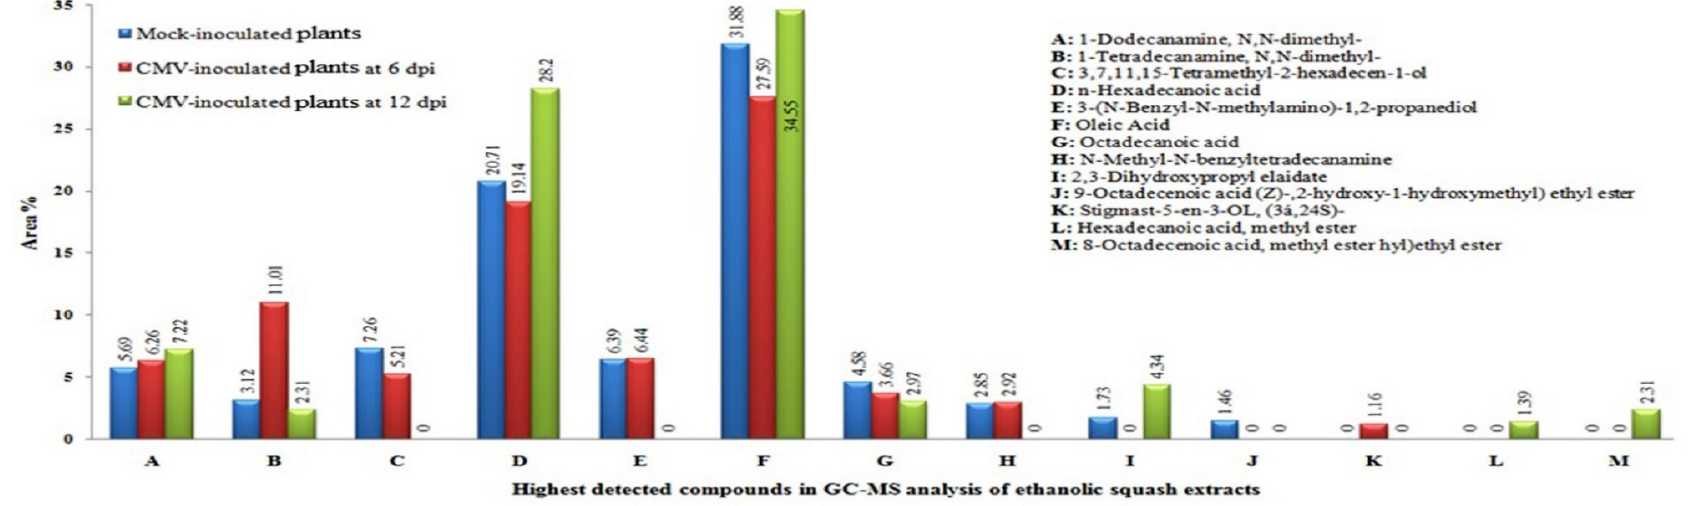
Figure 9. Comparison between the highest detected compounds and their area % (represented above the columns) in the ethanolic extract of squash plants in mock-inoculated plants and CMV-inoculated plants at 6 and 12 dpi.